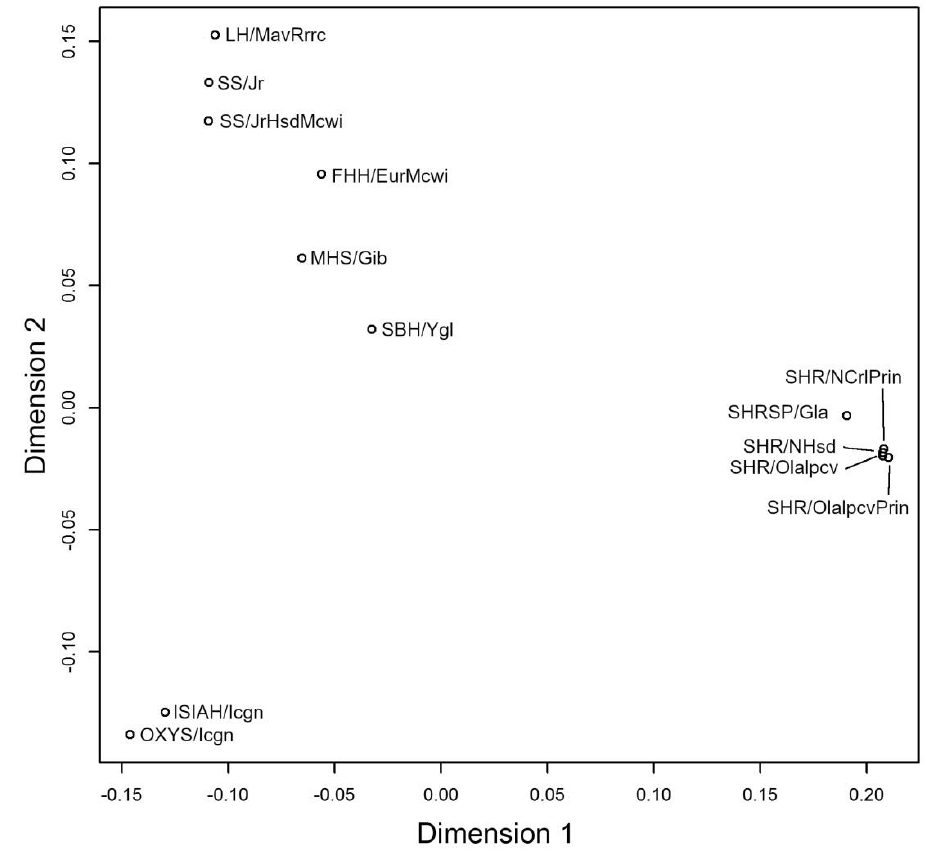
Figure 2. Multidimensional-scaling analysis of distances (allele identity by state) between the genotype of OXYS/Icgn rats and genotypes of 12 other hypertensive rat strains and substrains.